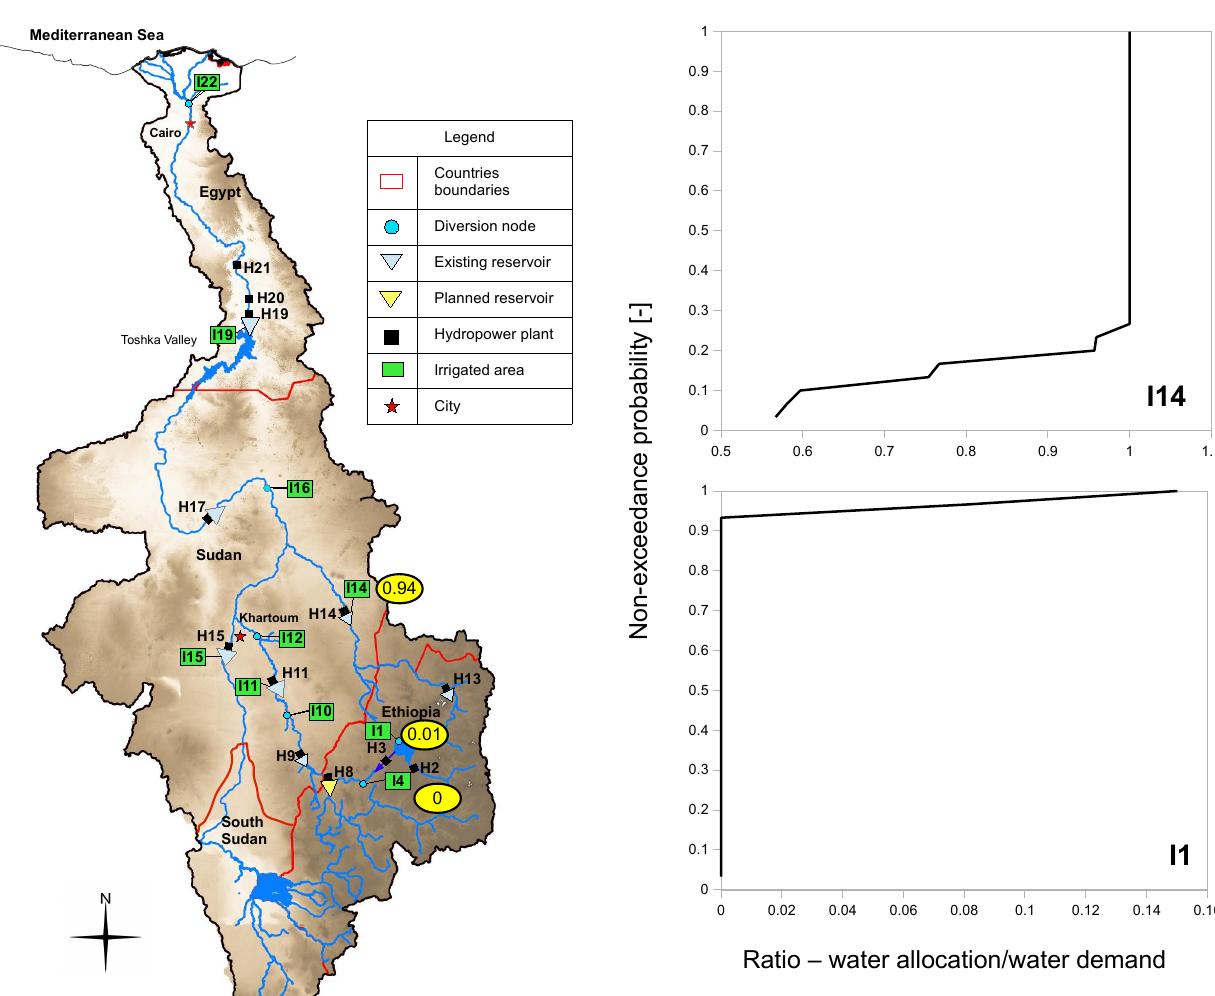
Figure 9. Cumulative distribution function for the proportion of wa- ter allocation to unconstrained demand for agents I1 and